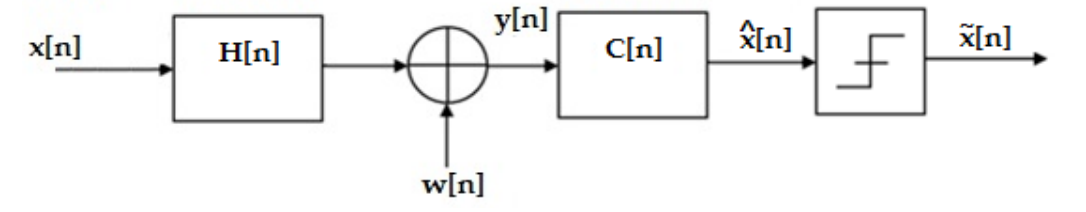
Figure 3. Discrete channel model [10].